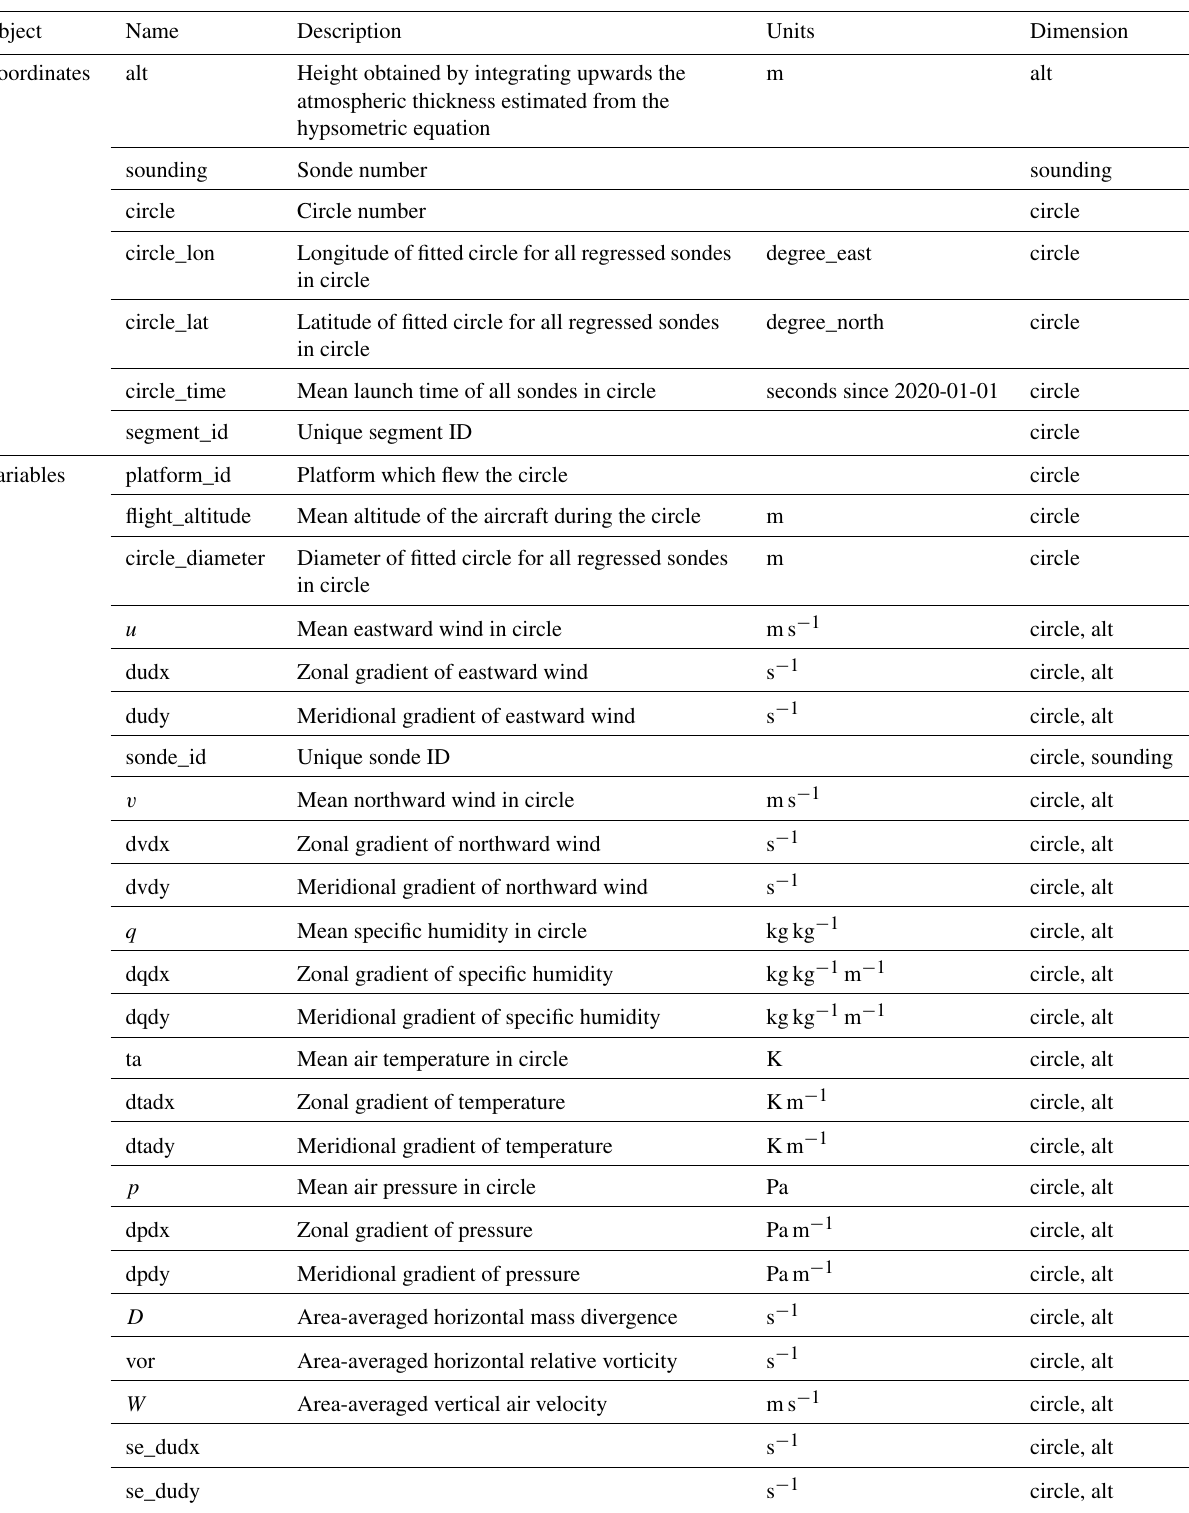
Table 9. The structure for the Level-4 product, outlining the coordinates and variables and their corresponding descriptions, units and dimensions. The ancillary variables (with the prefix “se_”) give the standard error for their corresponding variables indicated by the suffix in the